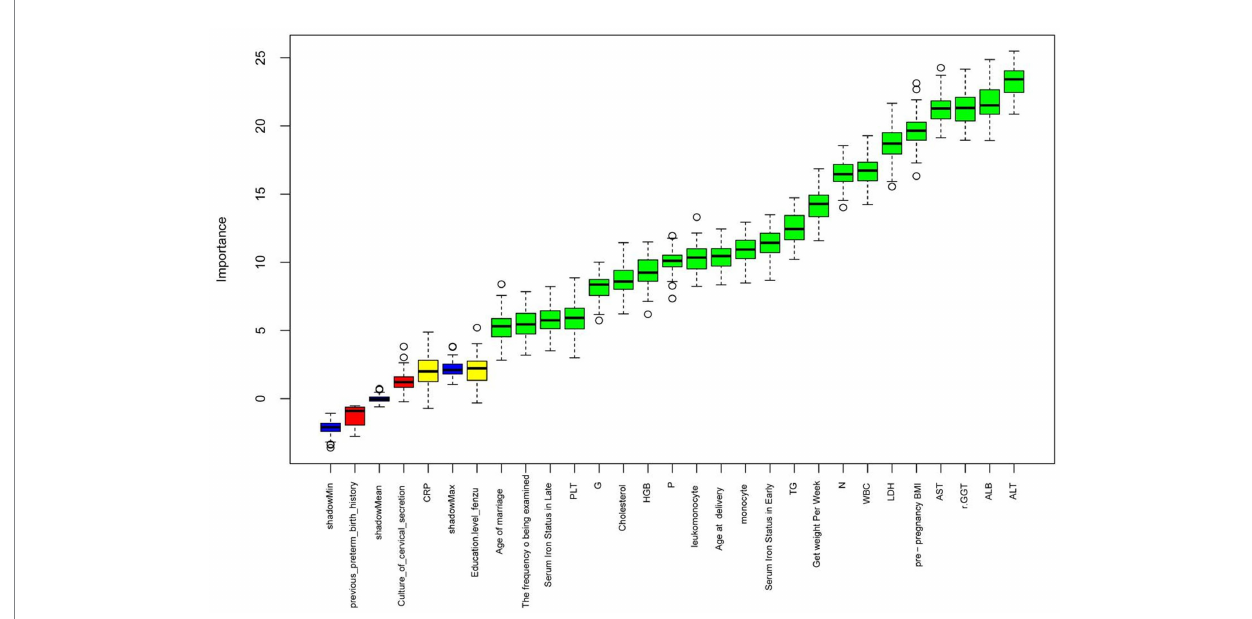
FIGURE 2 Schematic diagram for assessing the importance of variables. (The horizontal axis is the characteristic variable predicting hypertensive disorders in pregnancy, the vertical axis is the importance score, green is the important variable, red is the insignificant variable, blue is the shadow variable and yellow is the Tentative